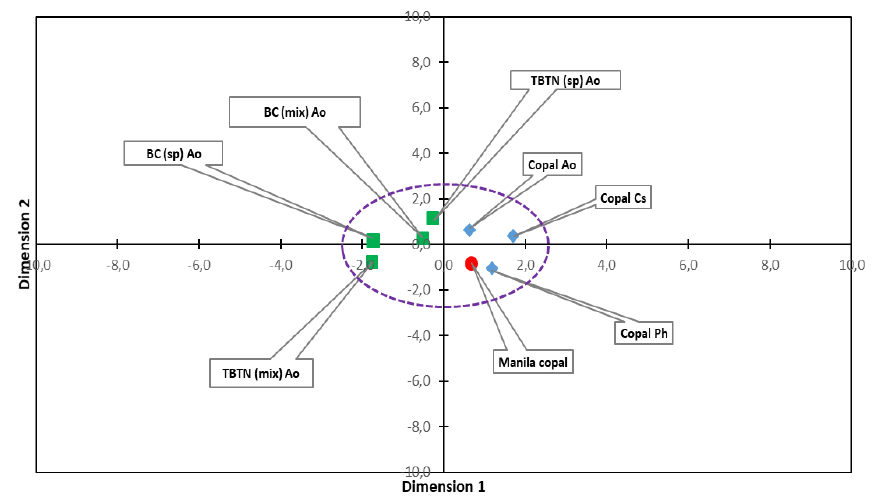
Figure 7. MDS analysis of Manila copal samples: blank sample (type 1, red circle); samples inoculated with microorganisms without biocide (type 3, blue diamonds); and samples inoculated with Ao and treated with the studied biocides (type 4 (mix), and 5 (sp), green squares). BC = benzalkonium chloride, TBTN = tributyltin naphtenate, and OPP = ortophenyl phenol. Cs = C. sitophila ; Ph = P. herbarum ; Ao = A. oxydans